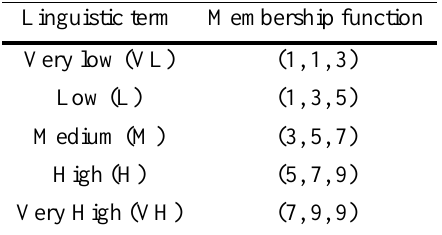
Table 2. Linguistic terms for criteria